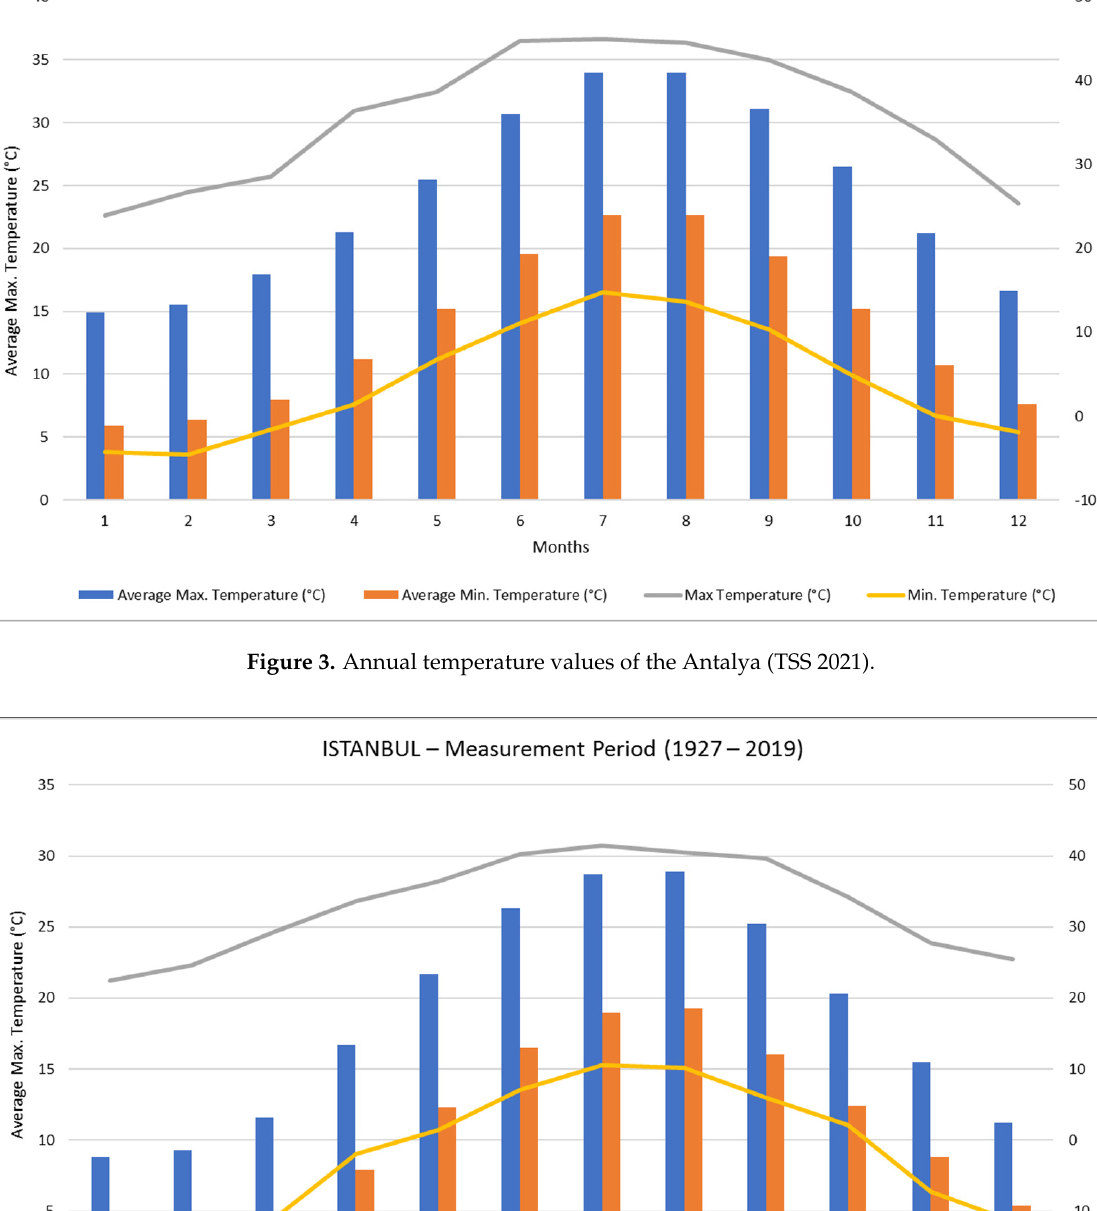
Figure 4. Annual temperature values of the Istanbul (TSS 2021).